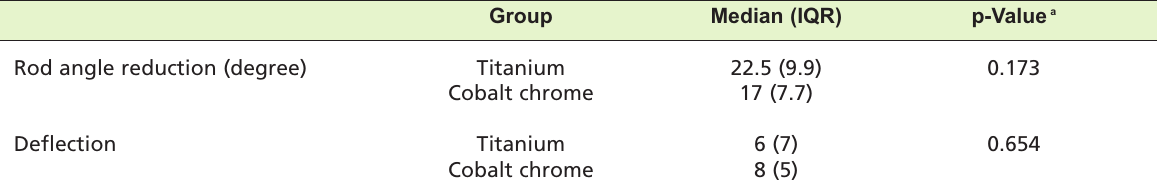
Comparison of rod deformation between titanium and cobalt chrome group Table III: